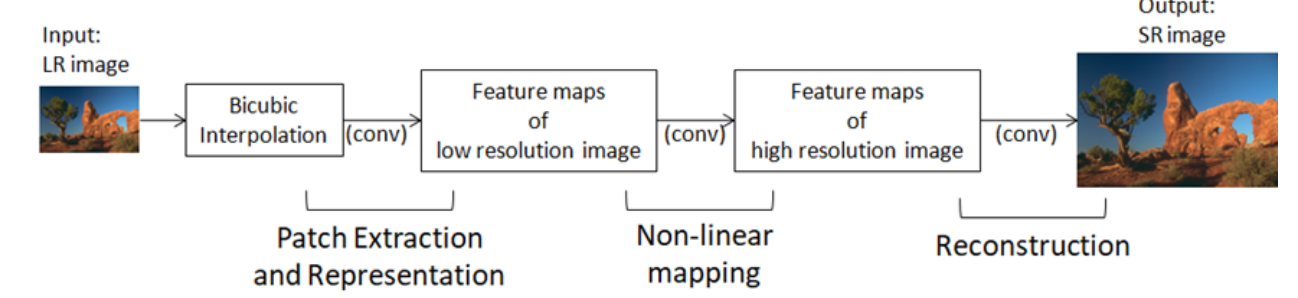
Figure 1. Flow for producing SR images using SRCNN.